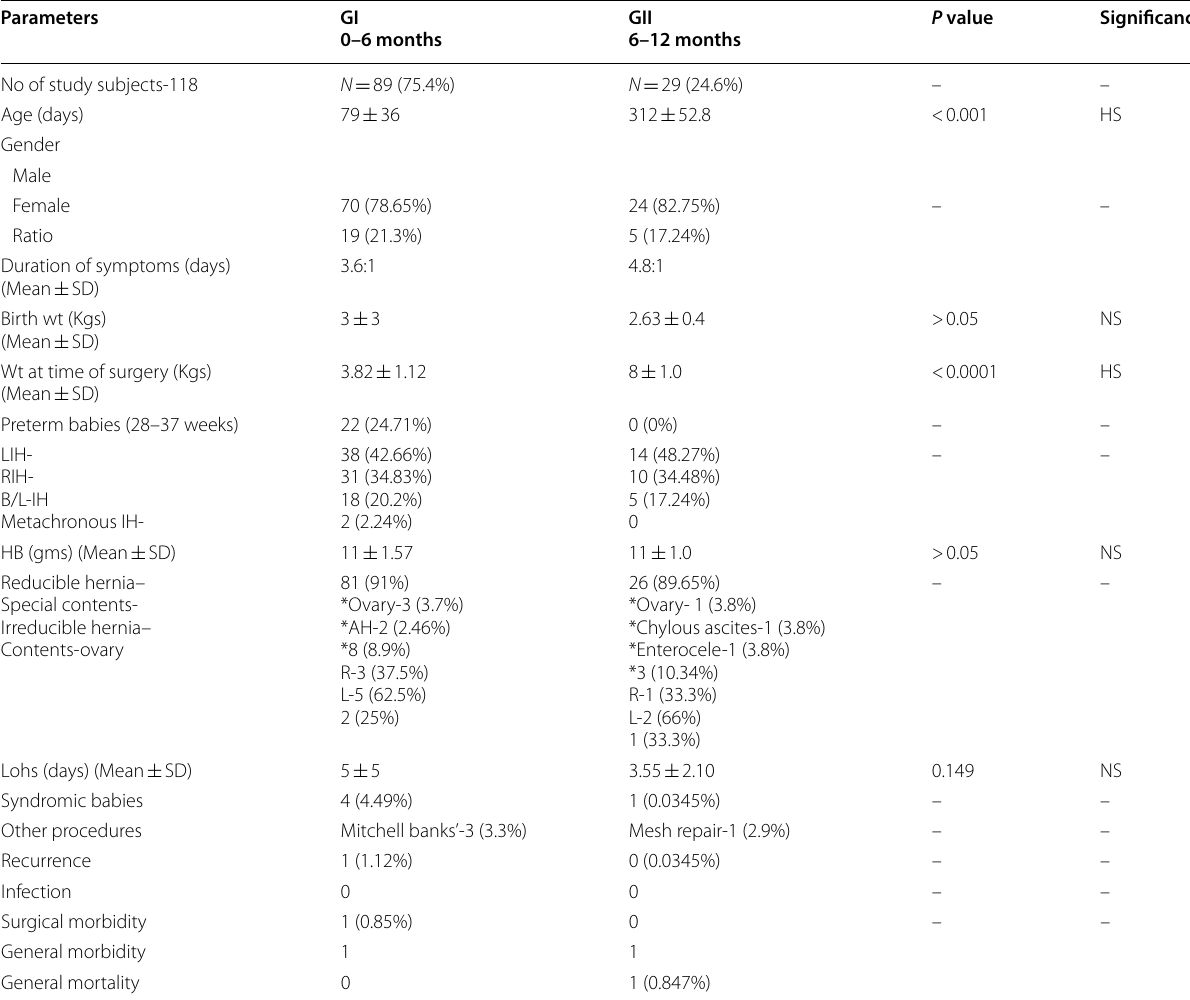
Table 1 Clinical profile of infantile inguinal